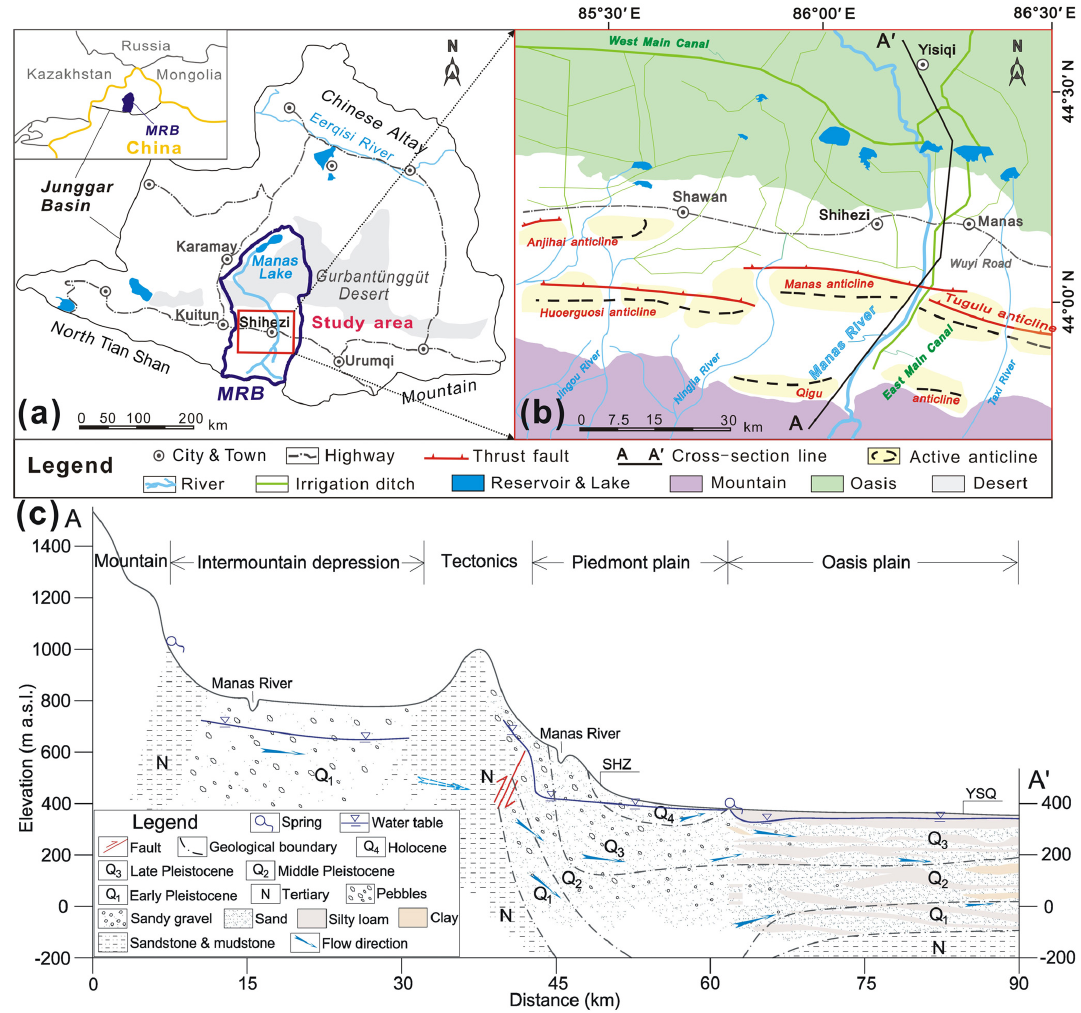
Figure 1. Maps showing (a) regional location of the Manas River Basin (modified after Ma et al., 2018), (b) surface water (river, reservoir and irrigation ditch) system (modified after Cui et al., 2007 and Ji, 2016) and (c) geological cross section of the study area for A–A (cid:48) line shown in (b)